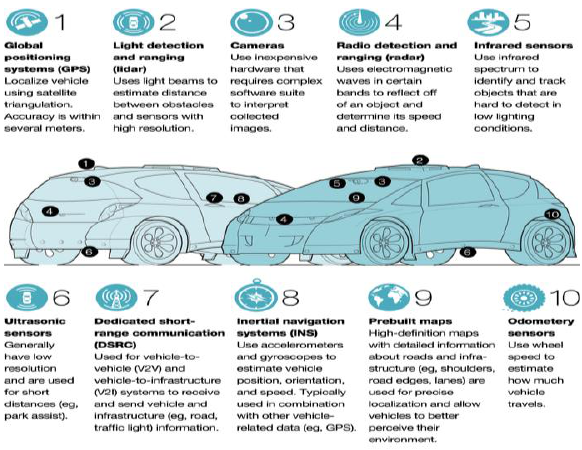
Figure 4. © The local components of an autonomous